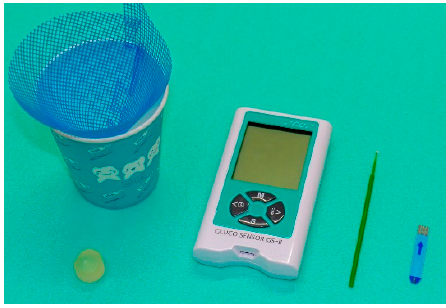
Figure 7 . Masticatory ability testing system Figure 7. Masticatory ability testing system.